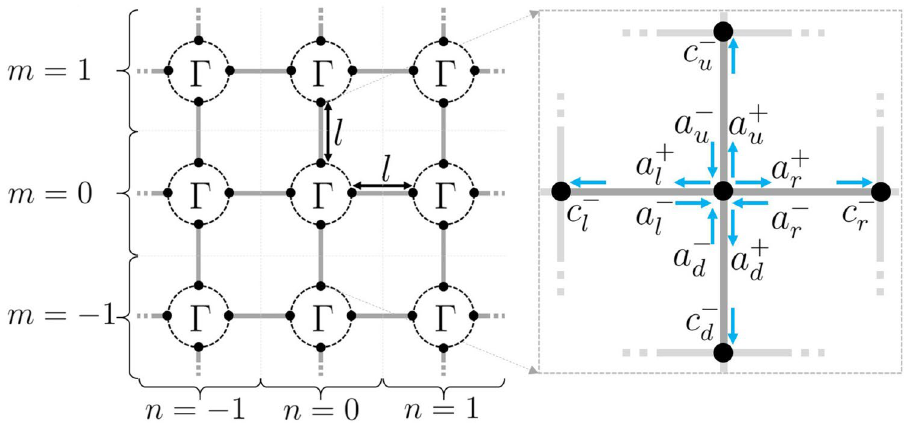
Figure 3. A 2D square periodic arrangement of quantum graph based resonant elements Ŵ( V , E , L ) connected by edges of length l as a model for a 2D metamaterial. Location n wave amplitudes, a ± and c − , traveling on the edges in the neighbourhood of the central